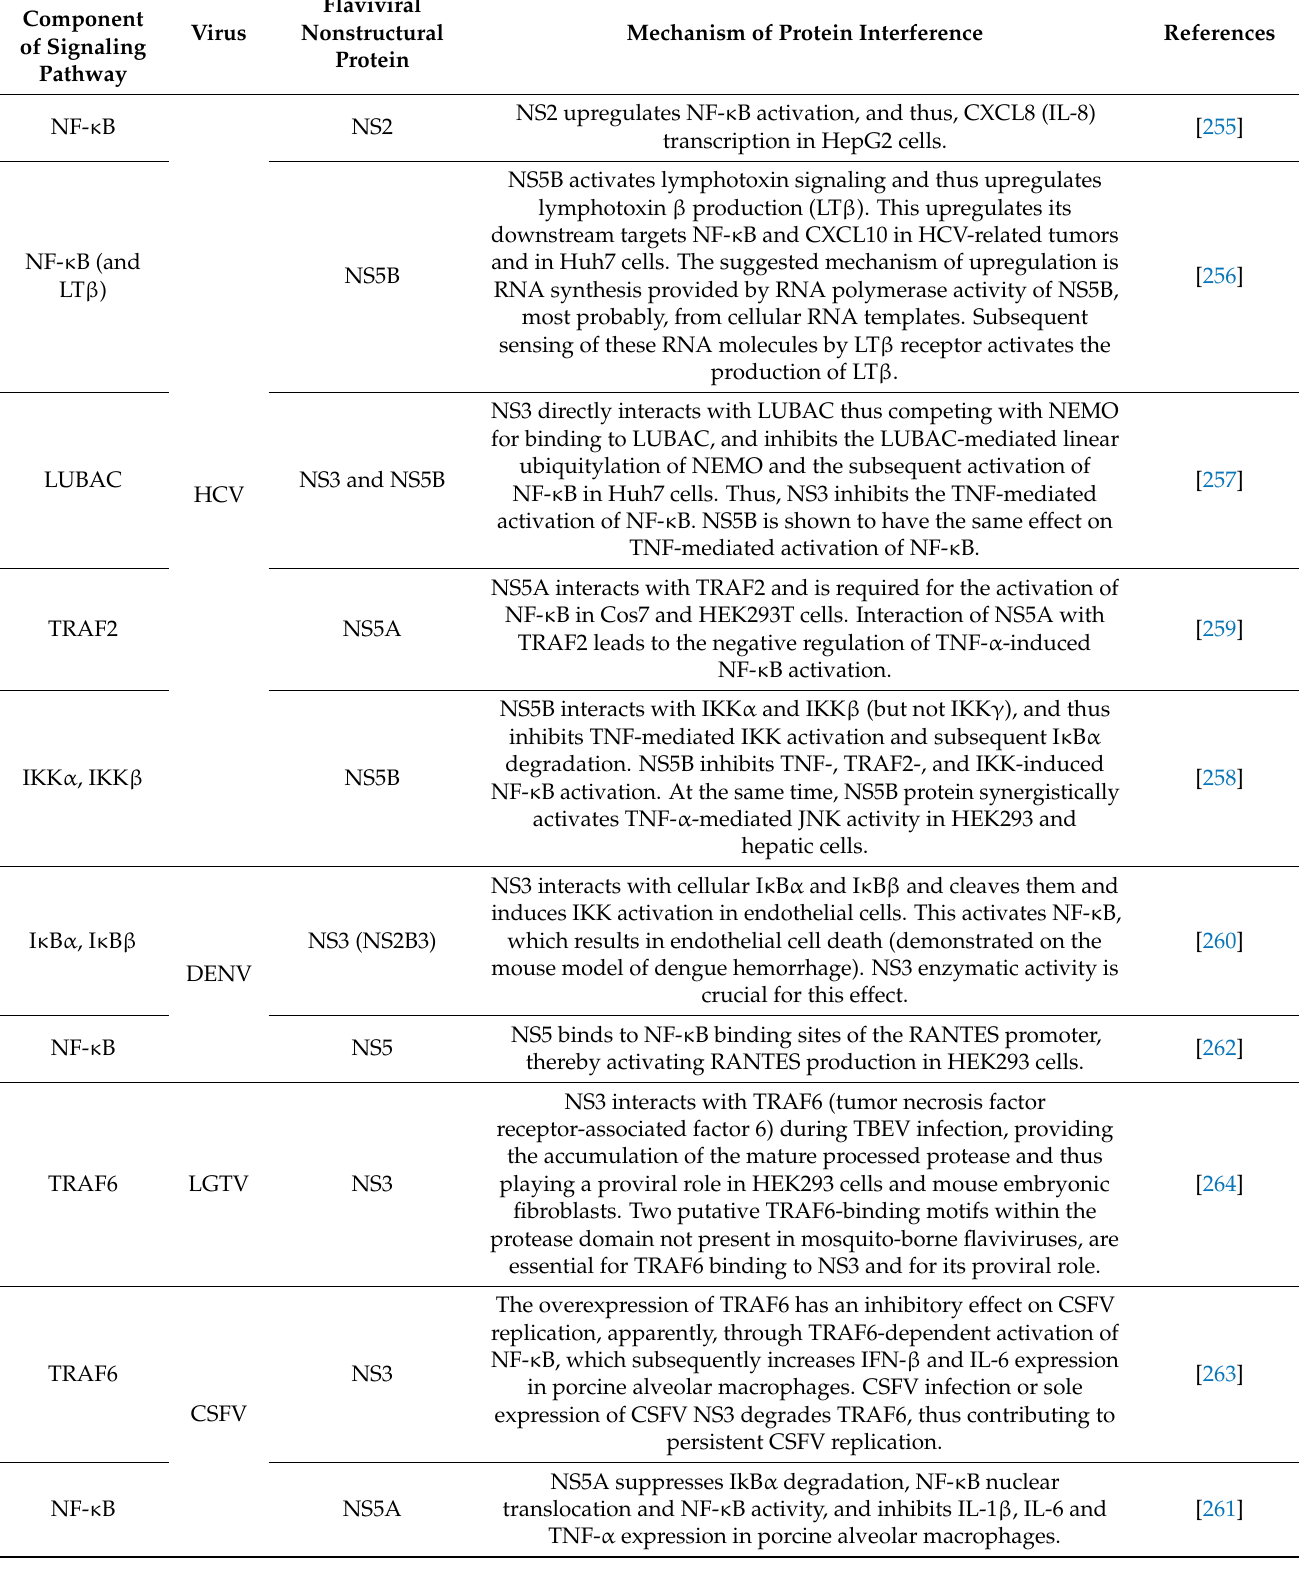
Table 3. Flaviviridae nonstructural proteins’ interference with NF- κ B